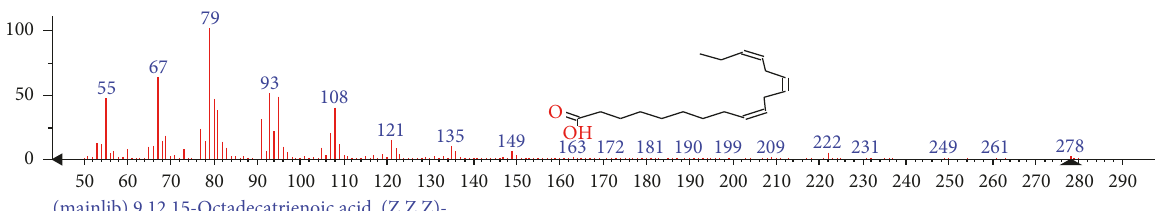
(Z,Z,Z)-50 60 70 80 90 100 110 120 130 140 150 160 170 180 190 200 210 220 230 240 250 260 270 280 (mainlib) 9,12,15-Octadecatrienoic acid, Figure 43: Mass spectrum of compound 9,12,15-octadecatrienoic acid, (Z,Z,Z)- of whole plant hexane fraction of Achillea wilhelmsii (WHFAW).